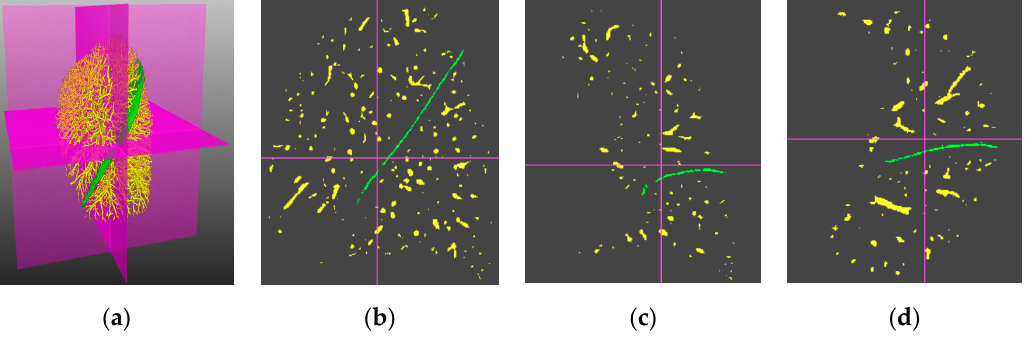
Figure 5. Investigate the shape feature of various pulmonary structures: ( a ) 3D visualization of a human lung, and its ( b ) sagittal slice, ( c ) coronal slice, ( d ) coronal slice.